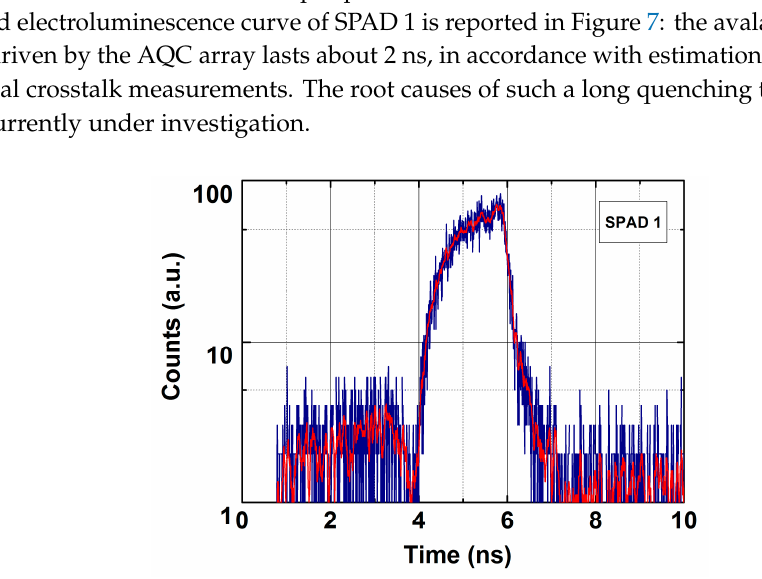
Figure 7. Electroluminescence of SPAD 1 avalanche acquired by directly facing a monitor SPAD detector in front of the 16 × 1 fast-gated SPAD array and acquiring inter arrival times between output pulses of the two detectors by means of a Time-Correlated Single-Photon Counting (TCSPC) instrument. Blue/Red line reports raw/filtered data.